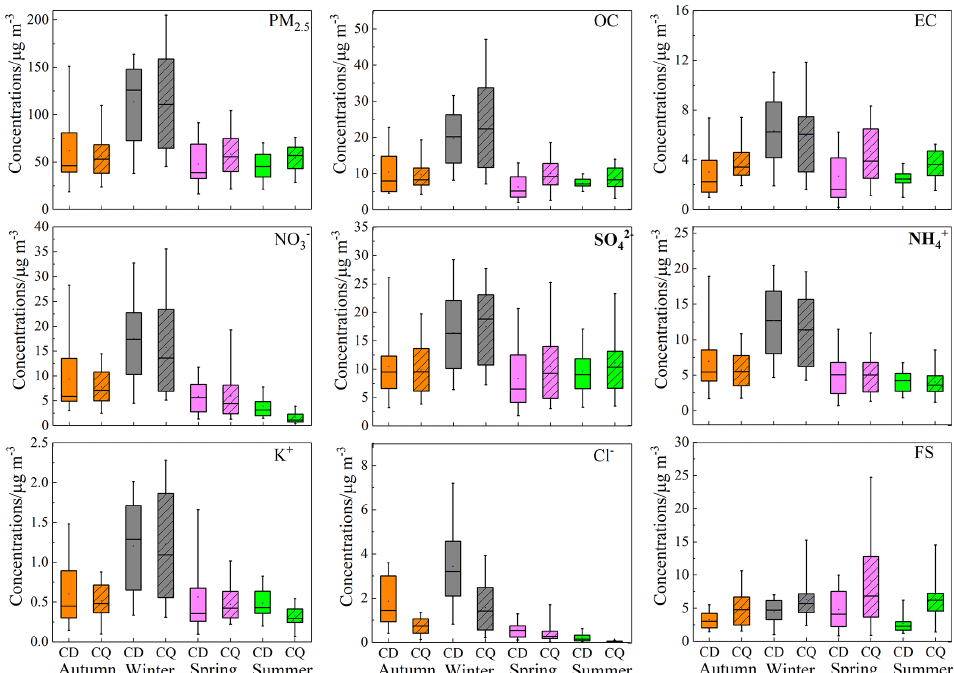
Figure 3. Seasonal distributions of PM 2 . 5 and its major chemical components. Shown in each sub-figure are mean (dot symbol), median (horizontal line), the central 50% data (25th–75th percentiles, box), and the central 90% data (5th–95th percentile,